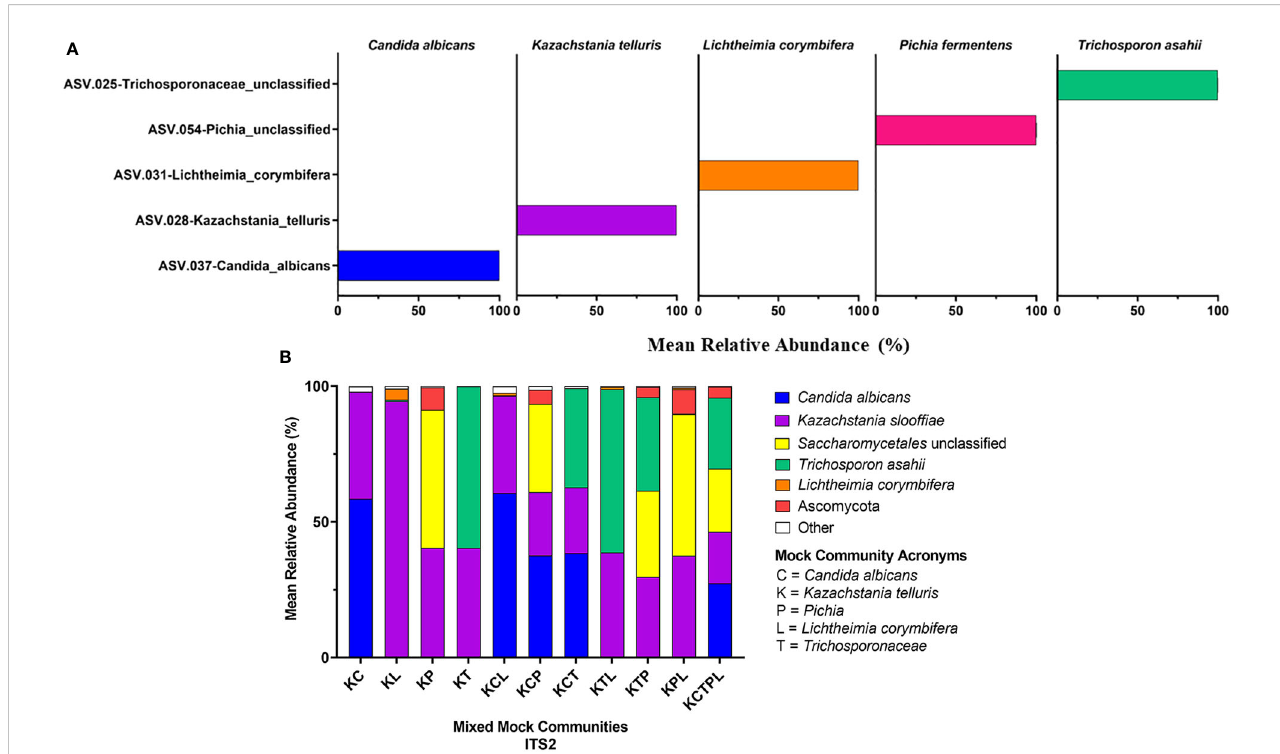
FIGURE 5 18S Sequencing Results. 18S primers were used to sequence individual fungal isolates, C albicans, K sloof fi ae, L. corymbifera, P. fermentans , and T. asahii (A) or mock communities ranging from 2 isolate combinations up to all 5 in one mock community (B) . Each mock community is represented on the x axis with an acronym representing the fungi in the mock community. C = Candida albicans , K = Kazachstania telluris , P = Pichia , L = Lichtheimia corymbifera , and T = Trichosporonaceae . Combinations are represented with the fi rst letter of each fungus found in each mock community, for example, KC = Kazachstania and Candida